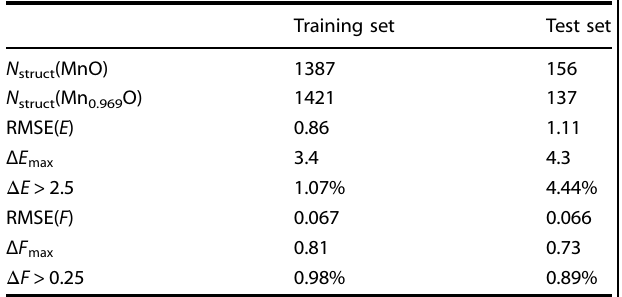
¼ 4 : 462 Å . The FM